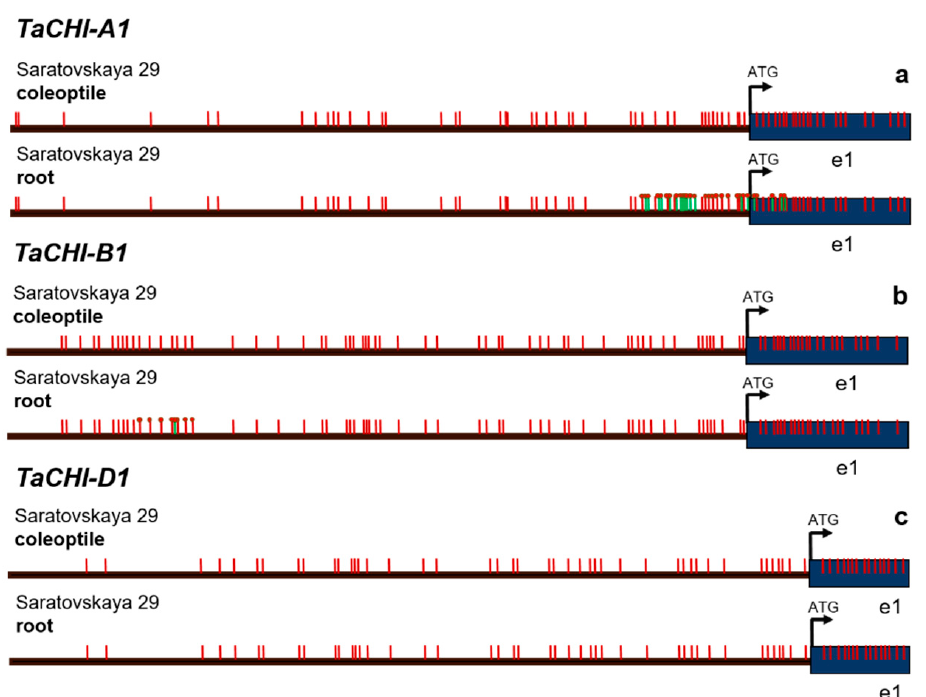
Figure 3. Methylation patterns of promoter regions for the ( a ) TaCHI-A1 gene (799 bp), ( b ) TaCHI-B1 (923 bp), and ( c ) TaCHI-D1 (715 bp) in the wheat coleoptile and roots. Arrows indicate the primers. Vertical red strokes are the predicted methylation sites. Vertical green strokes are the detected non-canonical methylation sites. Red circles mark the detected methylation site. Table 3. Methylation status of regulatory motifs in the TaCHI s and TaF3H s promoter sequences. R